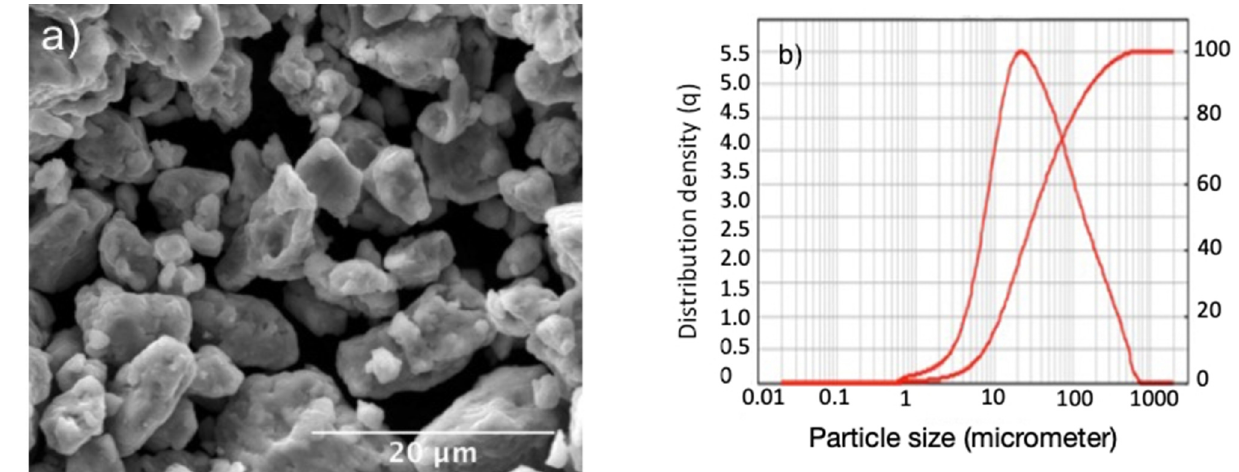
Figure 1. ( a ) Morphology of the mechanically alloyed powders; ( b ) particle size normalized and cumulative distribution. cumulative